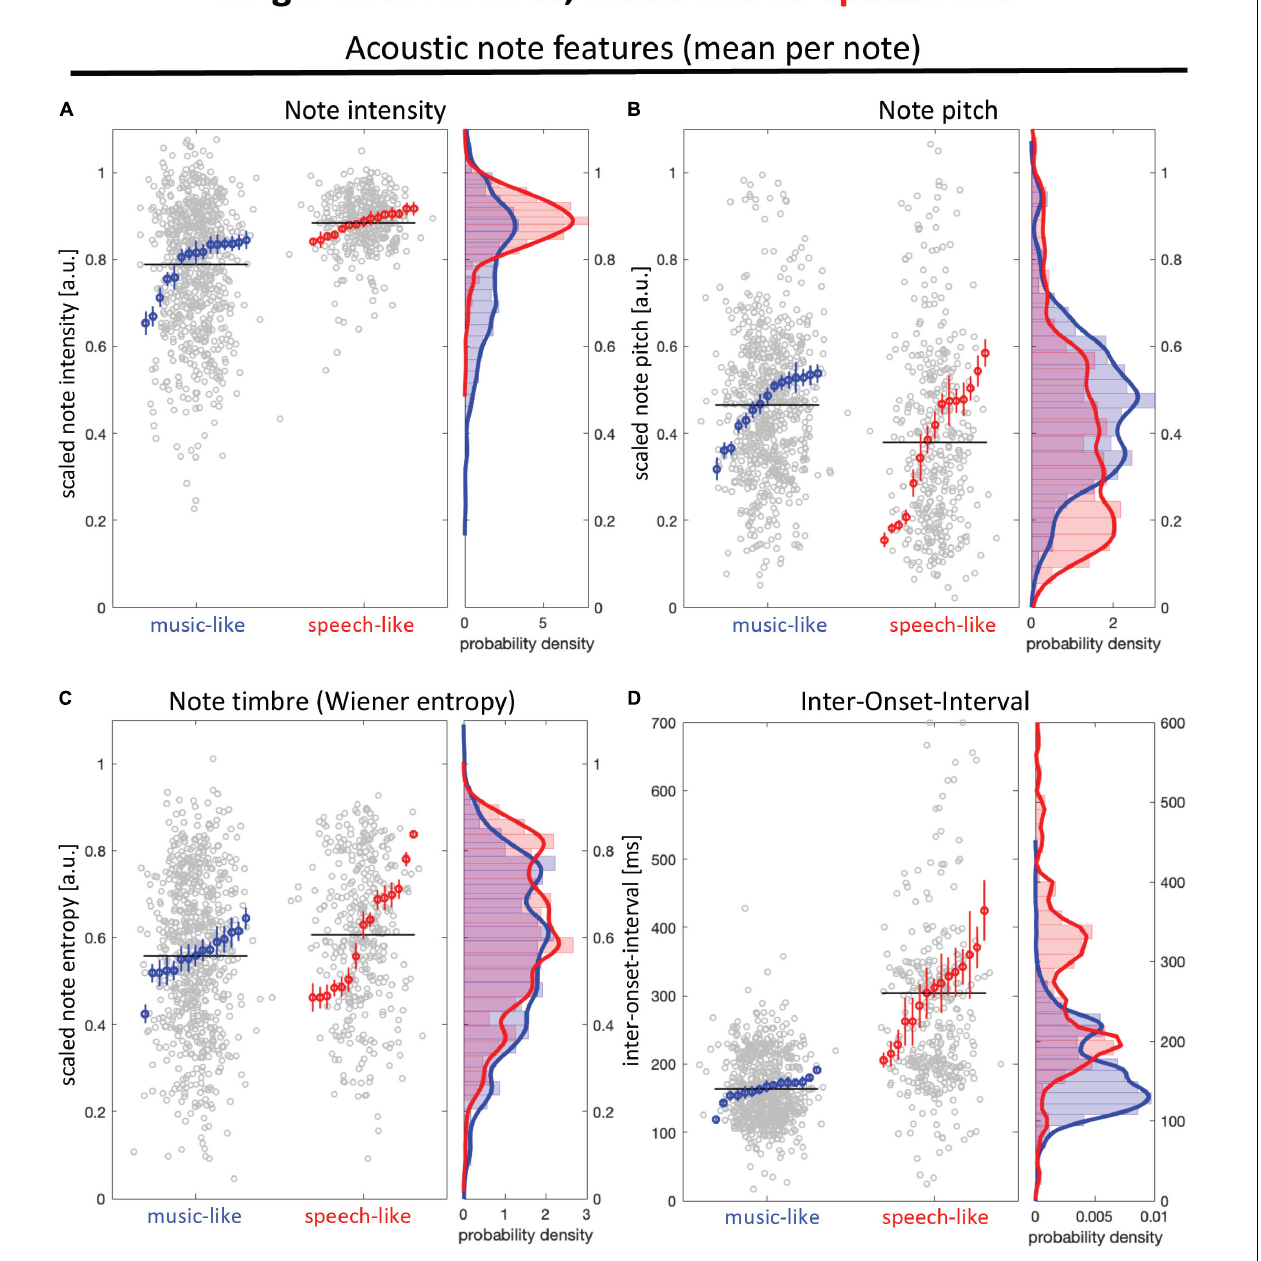
FIGURE 3 | Acoustic measures computed at the note level for music-like (blue) and speech-like (red) dùndún performances. (A) Mean intensity, (B) Mean pitch, and (C) Mean timbre (Wiener entropy) (D) Mean inter onset intervals (IOI). Left panels show mean note values for 15 speech- and music-like pieces each in gray, with mean and SEM per piece in color. Right panels show the respective probability